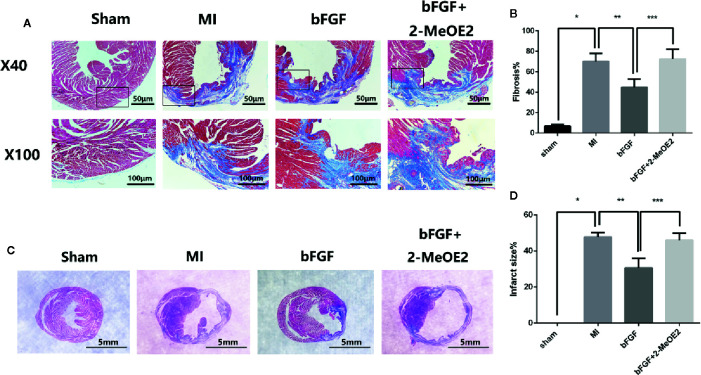
Decrease in the infarcted area and fibrosis in the infarcted zone. (A, B) Effects of bFGF on the infarcted area and LV remodeling. Representative images of Masson’s trichrome staining in myocardial sections (5 μm) from the sham, MI, bFGF, and bFGF + 2-MeOE2 groups (40×, 100×). Blue indicates collagen, and red indicates viable myocardium. *
P<0.05 vs. sham group. **
P<0.05 vs. MI group. ***
P<0.05 vs. bFGF group (n=5). (C, D) Effects of bFGF on the infarcted area and infarct size. Paraffin-embedded tissues were stained with Masson’s trichrome, and the ratio of the infarcted area to the left ventricle field was evaluated. *
P<0.05 vs. sham group. **
P<0.05 vs. MI group. ***
P<0.05 vs. bFGF group (n=5).